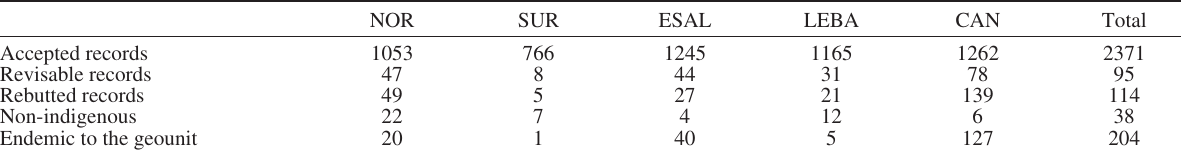
Table 3. – Number of molluscan species recorded in Spanish jurisdictional waters, by demarcation and status. The total of endemic species is slightly more than the sum because some species are found in several demarcations, yet endemic to Spanish waters as a whole. The total of globally rebutted records is less than the sum of demarcations, because locally rebutted records may be accepted in other